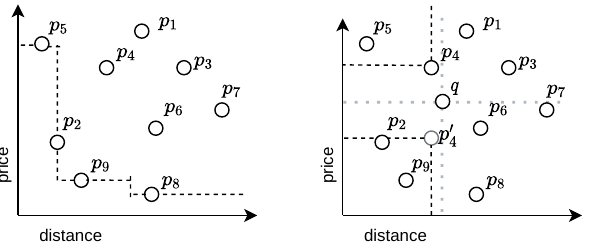
Figure 1. Geometric interpretation of the skyline problem and the dynamic skyline problem. ( Left ): All feature vectors to the upper right of the dashed line segments are dominated by one of the elements of the skyline set. The dashed line segment is also called the Pareto front of the dataset. ( Right ): For computing the dynamic skyline set with respect to the query point q , we can see that p 4 not only dominates p 5 , but also p 9 and p 2 if we mirror p 4 along the x-plane crossing q to obtain p (cid:48)